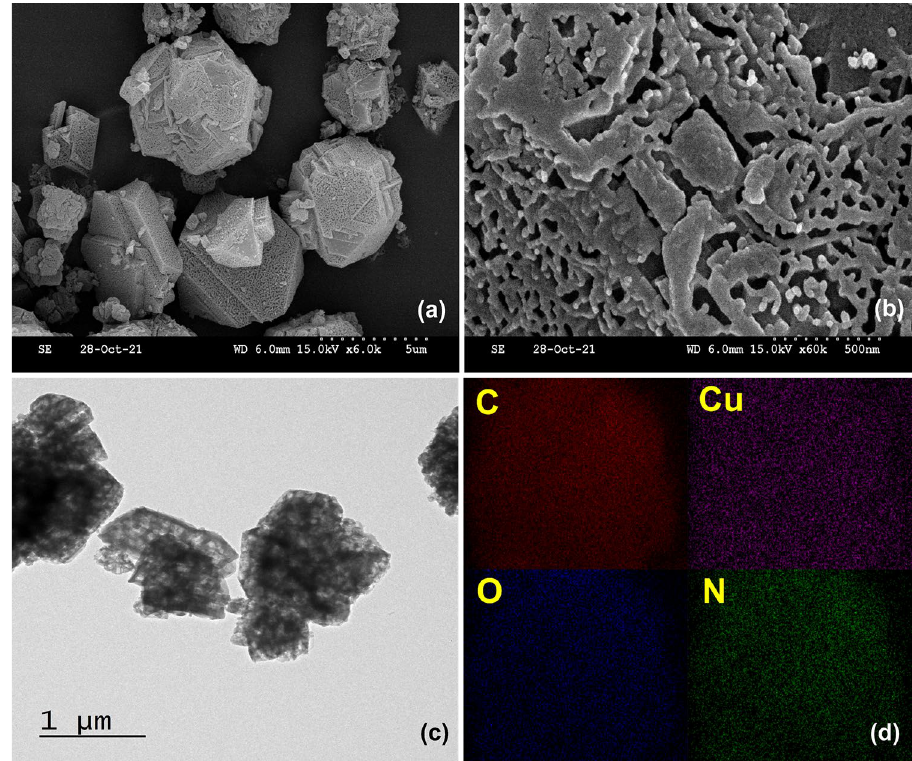
Figure 1. ( a, b ) SEM micrographs; ( c ) TEM micrograph; ( d ) SEM-EDAX analysis of